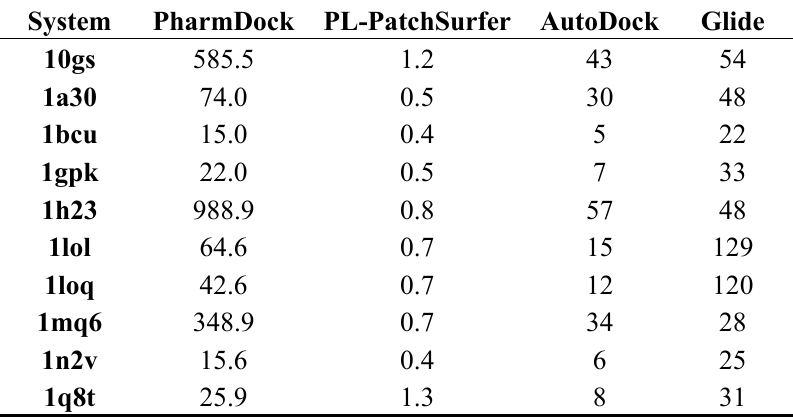
Table 5. Computational time of four methods.